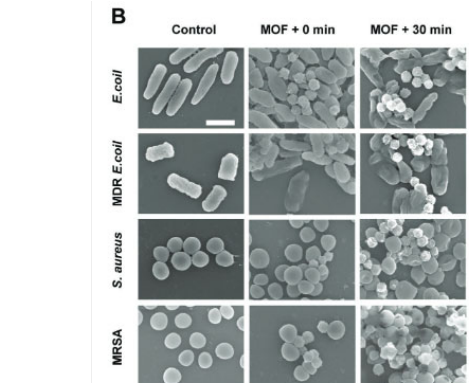
Figure 11. ( A ) The structure of the linker TCPP used for synthesis of PCN-224. ( B ) SEM images of bacterial morphology. Reproduced with permission from [90] .